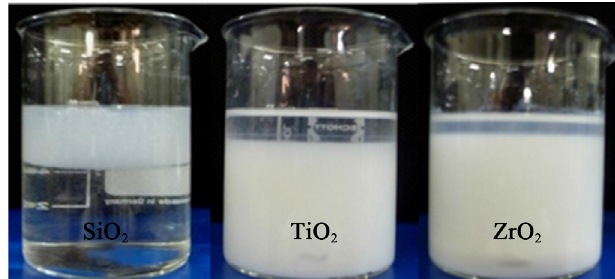
Fig. 7. Hydrophilic and hydrophobic properties of